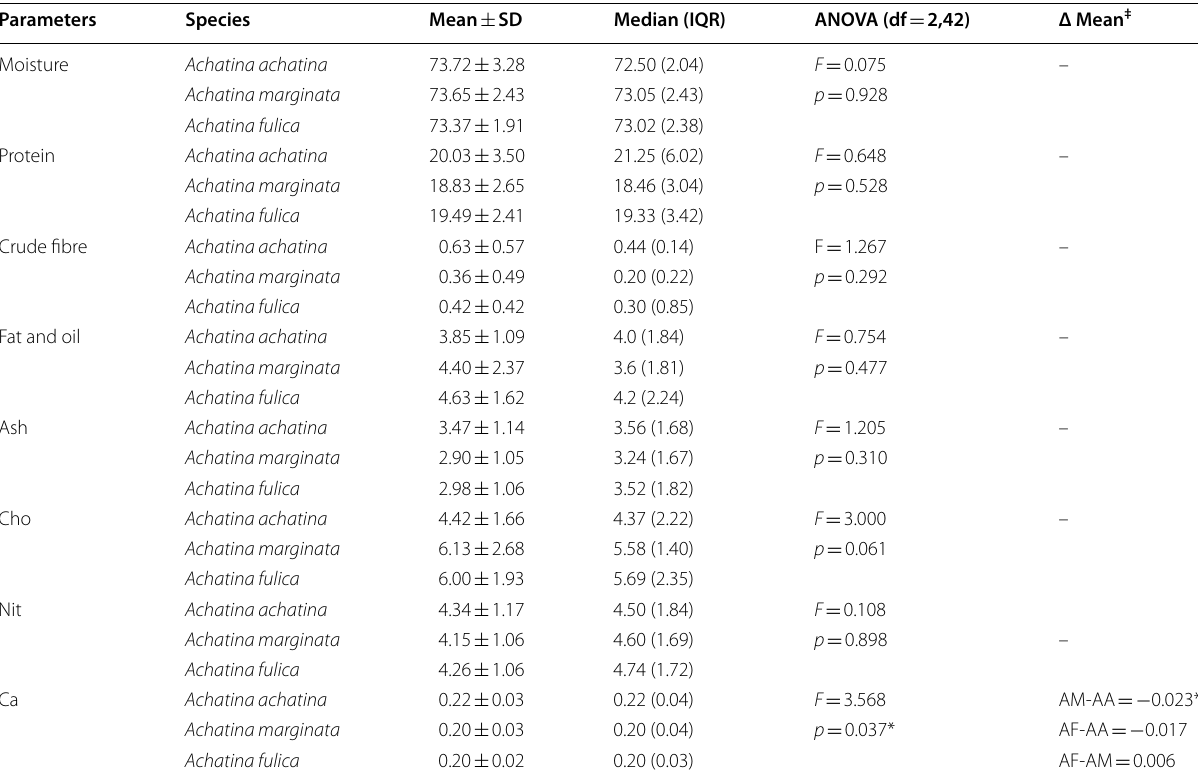
Table 1 Proximate composition of Achatina species collected from some rural agro-settlements, south-east Nigeria